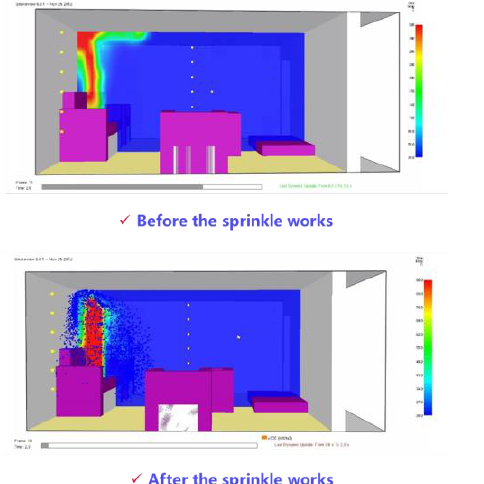
Figure 6. The simulation results from FDS for validation of sprinkle-spray